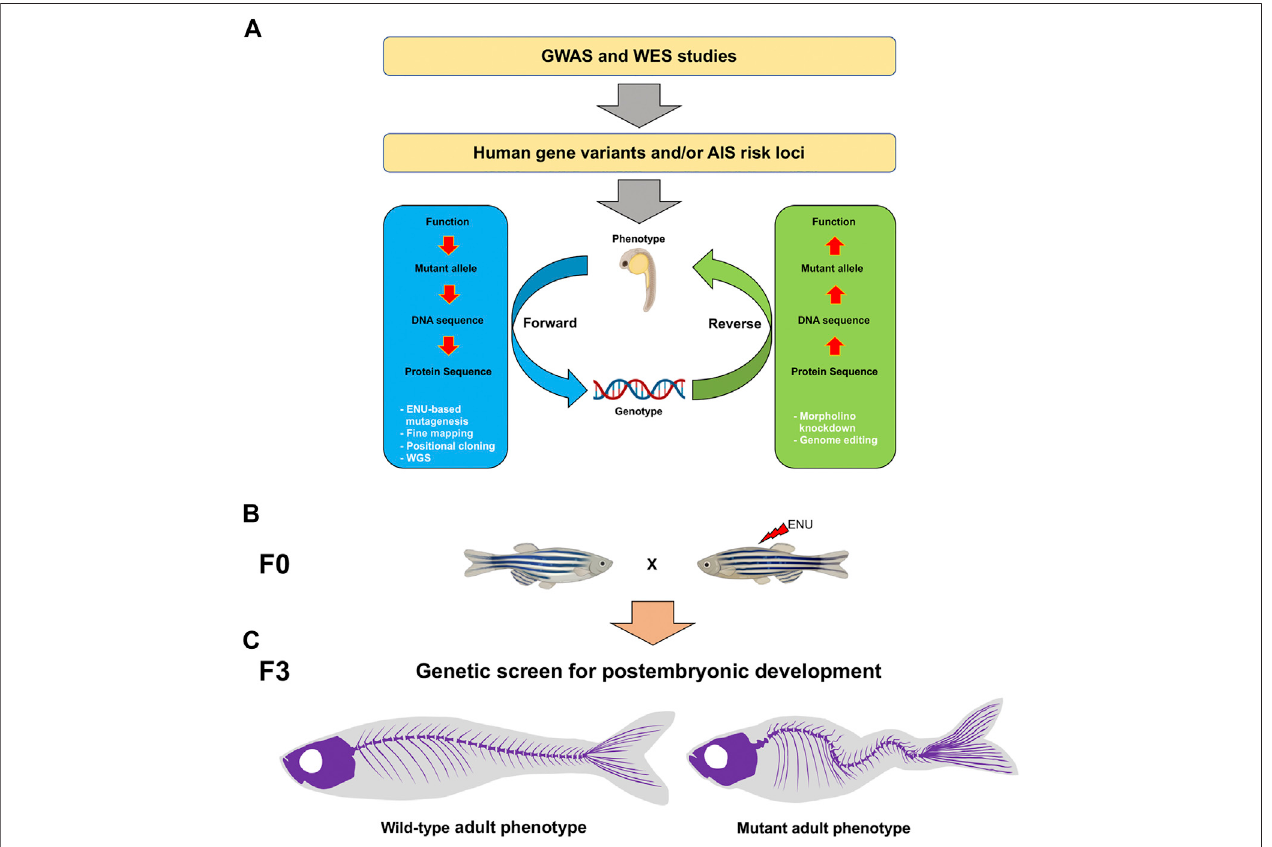
FIGURE 1 | Schematic of the genotype-phenotype association and genetic approaches to study AIS candidate genes in the zebra fi sh. (A) To identify AIS risk loci, GWAS and WES strategies can be performed. Forward (blue) and reverse (green) genetic strategies (white) are powerful tools to study mutant genotypes and phenotypes associated with AIS. (B) In a forward genetic screen, male founders (F0) are mutagenized with ENU and then outcrossed to generate F2 families. To screen forpostembryonicgenefunctionsinlatelarvaltoadultstagesafter5 dpf,F3familiesaregeneratedeitherthroughincrossingF2heterozygous fi shorthroughinvitro fertilization (IVF) using cryopreserved sperm and wild-type females, and raised to adulthood. (C) By using a combination of morphological, tomographic, molecular and cellular approaches, F3 individuals are screened for adult spine alterations. AIS, adolescent idiopathic scoliosis; GWAS, genome-wide association studies; WES, whole exome sequencing; ENU, N-ethyl-N-nitrosourea; WGS, whole genome sequencing.